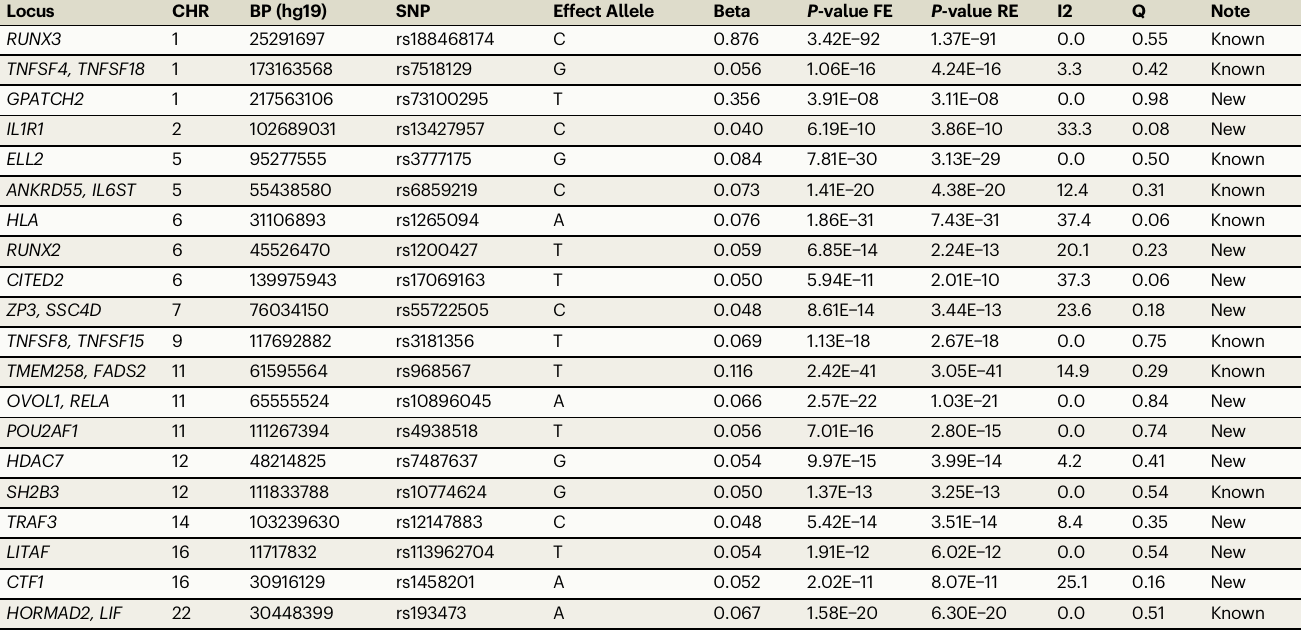
Table 2 | Effect estimates for 20 genome-wide signi fi cant loci for IgA levels by trans-ancestry meta-analysis